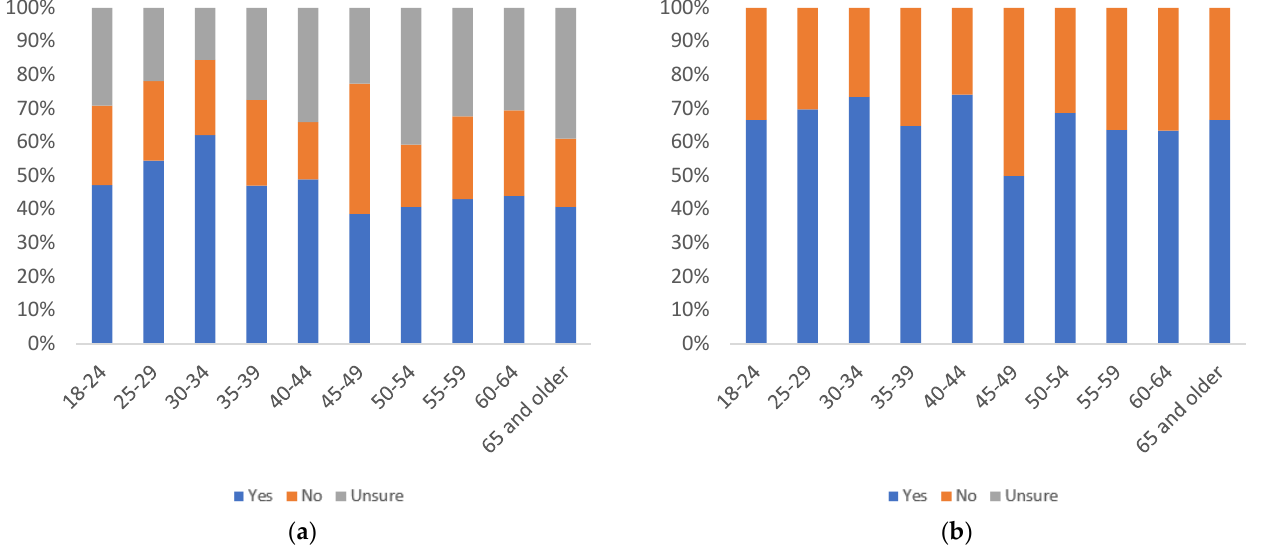
Figure 14. Label others’ use, by age group: ( a ) with uncertain respondents (left) and ( b ) without uncertain respondents (right).